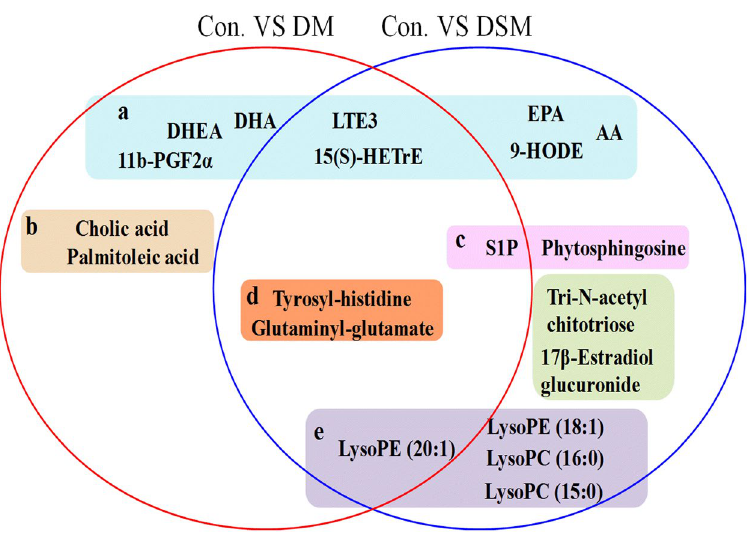
Figure 7. Identification of potential metabolites related to disease model rats and DS model rats. The color represent different classes of biomarkers: ( a ) arachidonic acid metabolism, linoleic acid metabolism; ( b ) fatty acid biosynthesis; ( c ) sphingolipid metabolism; ( d ) amino acid metabolism; ( e ) glycerophospholipid metabolism. DHA: docosahexaenoic acid; LTE3: leukotriene E3; 15S-HETrE: 15(S)-hydroxyeicosatrienoic acid; DHEA: 8,11,14-eicosatrienoyl ethanolamide; EPA: eicosapentaenoic acid; AA: arachidonic acid; S1P: Sphingosine